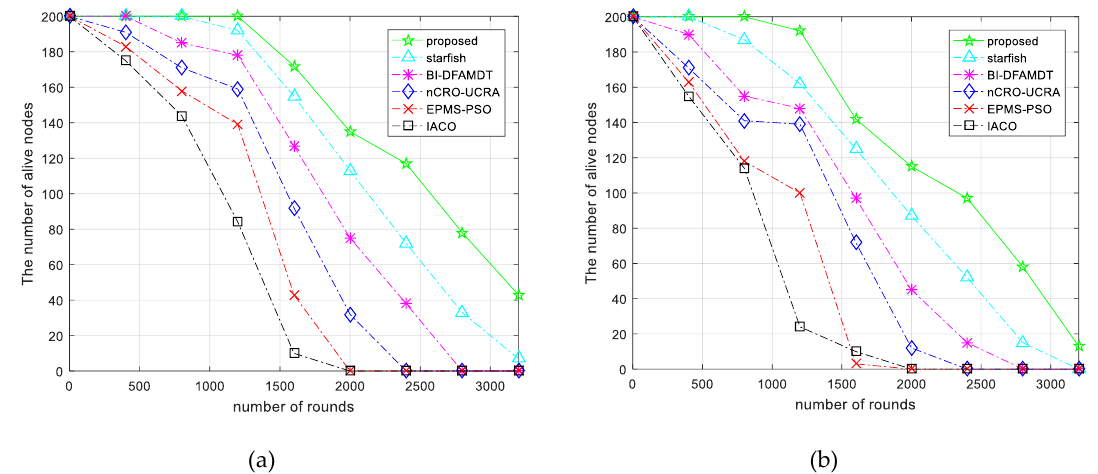
Figure 11. Comparison of the proposed scheme with existing algorithms versus number of alive nodes in the network: ( a ) Simulation graph for scenario 1; and, ( b ) Simulation graph for scenario 2. ii.